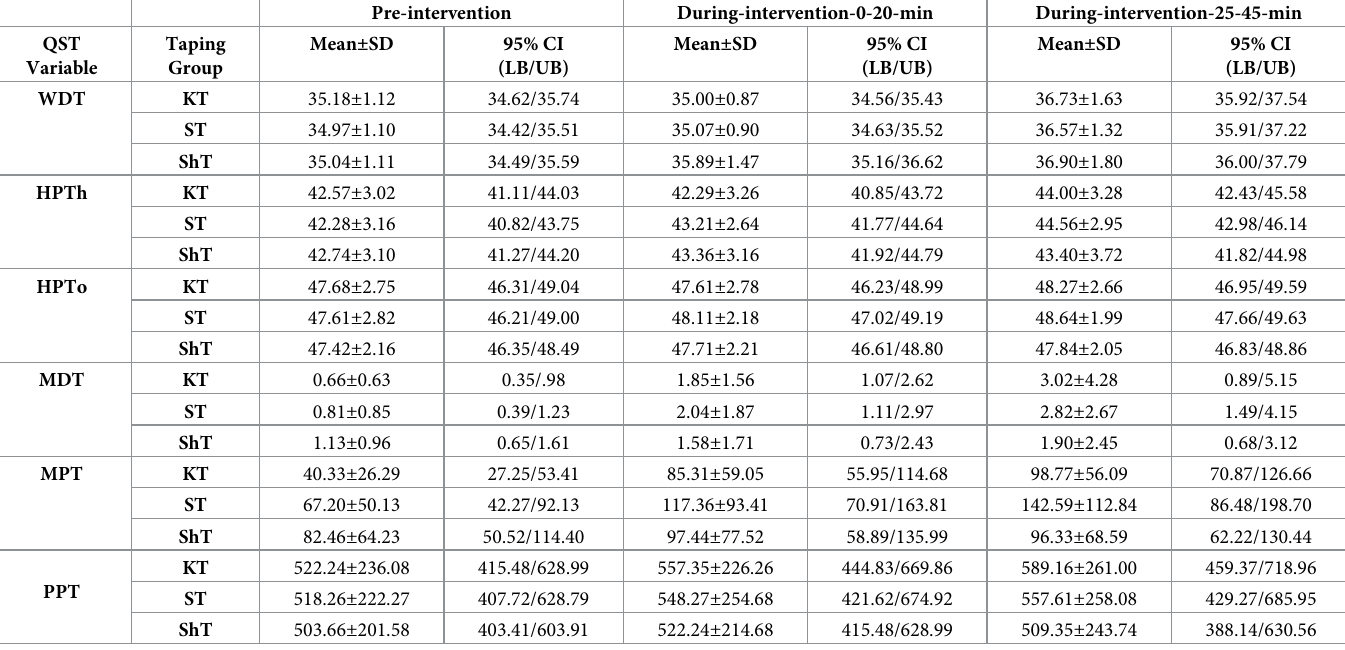
Table 2. Group x Time data mean and SD counts of WDT, HPTh, HPTo, MDT, MPT and